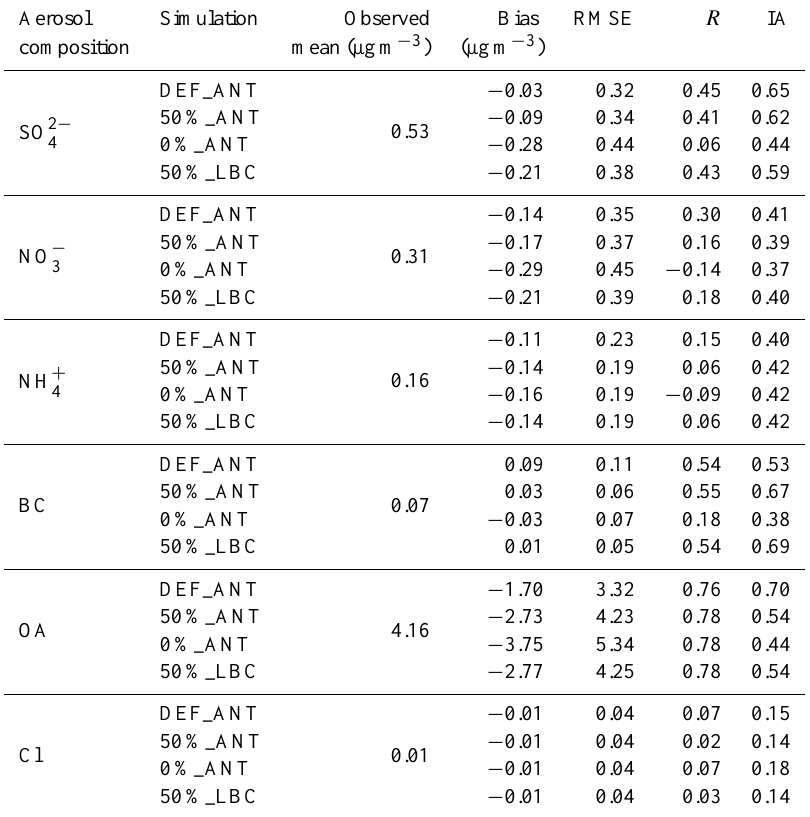
Table 11. Performance of simulated aerosol composition over all the G-1 flights in terms of bias, root-mean-square error (RMSE), correlation coefficient ( R ), and index of agreement (IA). Aerosol Simulation Observed